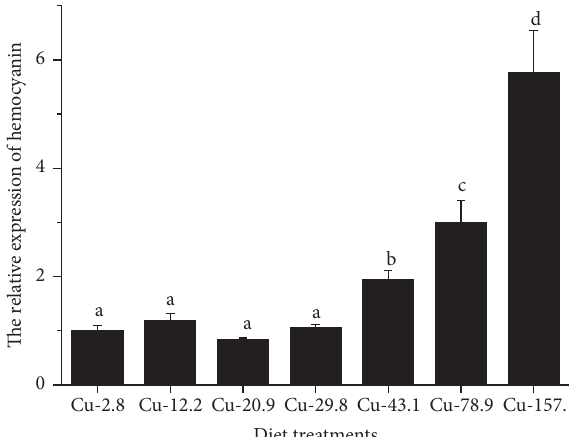
Figure 5: Relative hemocyanin mRNA levels in hepatopancreas of M. nipponense. M. nipponense was fed diet with different levels of copper for 8 weeks. Hemocyanin mRNA levels were evaluated by qRT-PCR and expressed relatively to the level of 𝛽 -actin mRNA. Different letters in each index indicated significant differences ( 𝑃 < 0.05